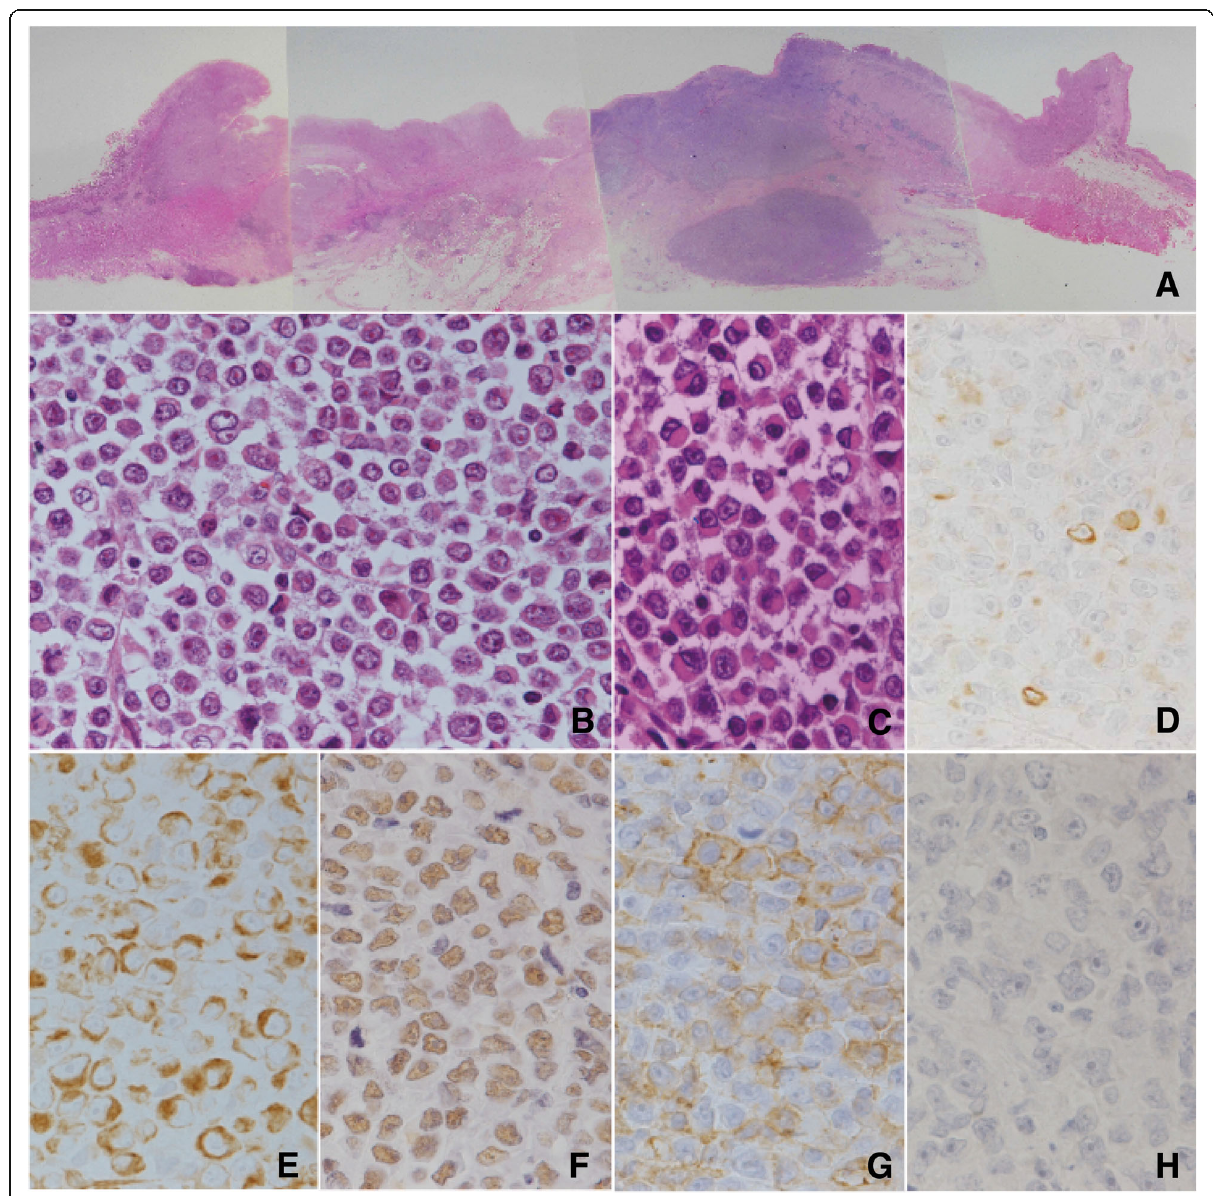
Fig. 3 Pathological findings of the resected primary tumor. A loupe image of the primary gastroesophageal region ( a HE) shows that the tumor invades the muscular layer in the esophagus and the subserosal layer in the stomach. In the primary tumor, large uniform round-shaped cells with relatively little cytoplasm were arranged in a diffuse pattern ( b HE, ×400), and some of the round cells showed prominent features of rhabdoid cells ( c HE, ×400). The round tumor cells were prominently vimentin positive ( e ×400) and weakly positive for cytokeratin (AE1/AE3) ( d ×400). The cells were also positive for SMARCB1 ( f ×400). The undifferentiated cells were positive for CD34 ( g ×400), but negative for c-kit ( h